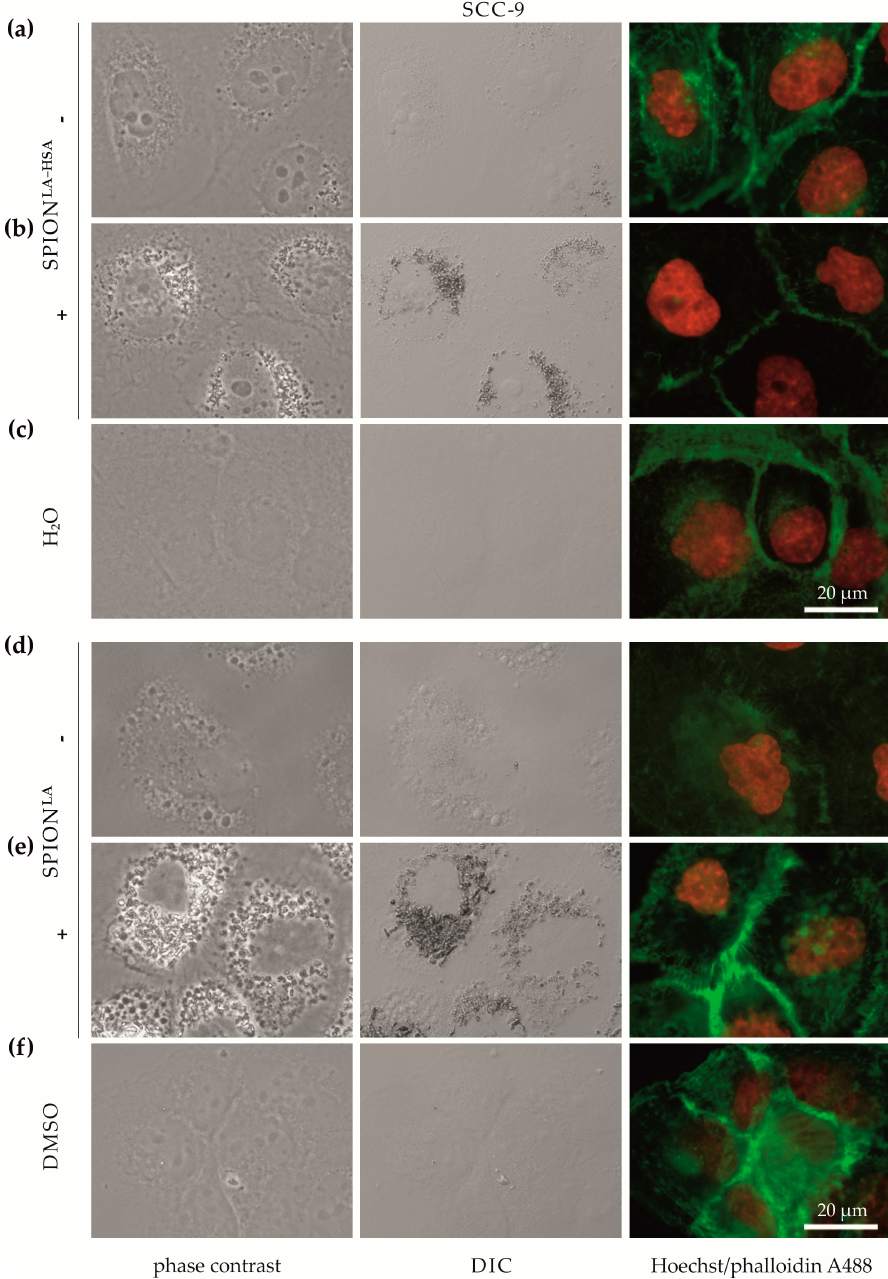
Figure 1. Optical imaging of SCC-9 cells incubated with SPIONs in the presence and absence of external magnets. Cells were treated with ( a , b ) SPION LA-HSA and ( d , e ) SPION LA (100 µgFe/mL) in the presence (+) or absence ( − ) of a magnet, or with the corresponding amount of ( c ) H 2 O or ( f ) DMSO (final concentration of 2%) for 48 h and visualized by phase contrast (first column), DIC (middle column) or fluorescence staining of nuclei (Hoechst 33342, red) and actin cytoskeleton (Alexa Fluor 488 Phalloidin, green) (last column). Abbreviations: SPION, superparamagnetic iron oxide nanoparticles; SPION LA , lauric acid-coated SPIONs; SPION LA-HSA , lauric acid- and human serum albumin-coated SPIONs; DIC, differential interference contrast; DMSO, dimethyl sulfoxide.